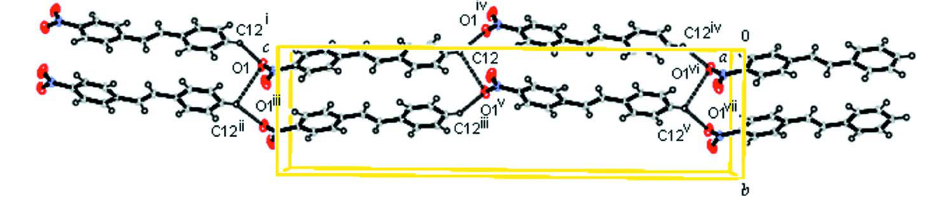
Figure 4 Part of the crystal structure of (I) showing the formation of edge-fused R 33 (28) rings along [001]. [Symmetry codes: (i) 3/2 - x , - y , 1/2 + z ; (ii) x , 1/2 - y , 1/2 + z ; (iii) 3/2 - x , 1/2 + y , z ; (iv) 3/2 - x , - y , -1/2 + z ]; (v) x , 1/2 - y , -1/2 + z ; (vi) x , y , -1 + z ; (vii) 3/2 - x , y , -1 + z